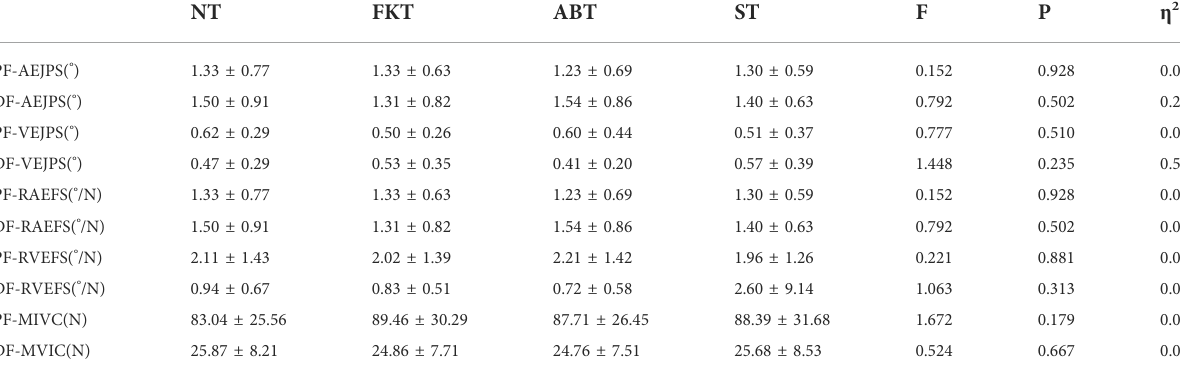
TABLE 1 Comparison of parameters in JPS, FS and MVIC among four taping treatments. NT FKT ABT